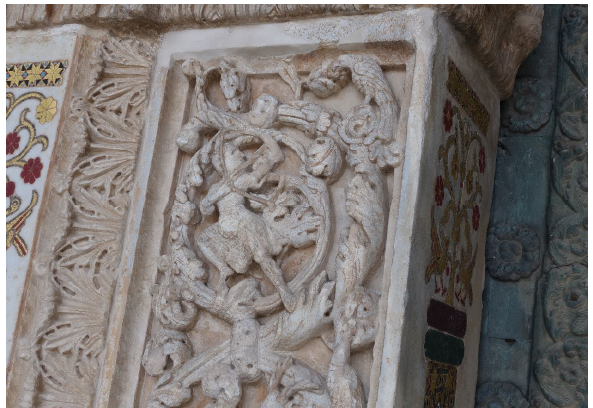
Figure 15. 3D model of the bas-relief in the right pilaster